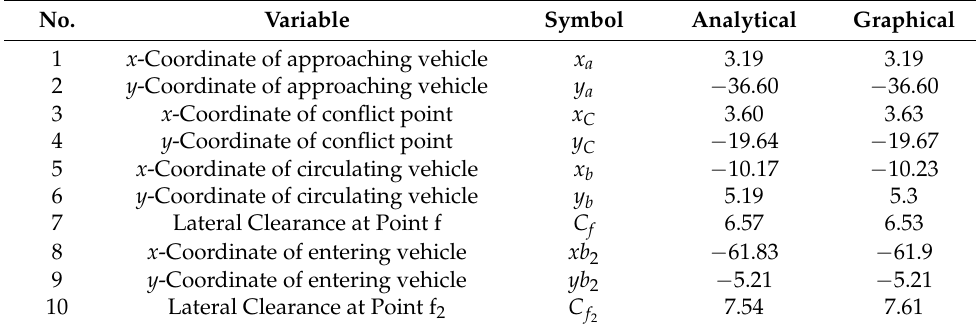
Table 2. Results of application example and comparison with graphical